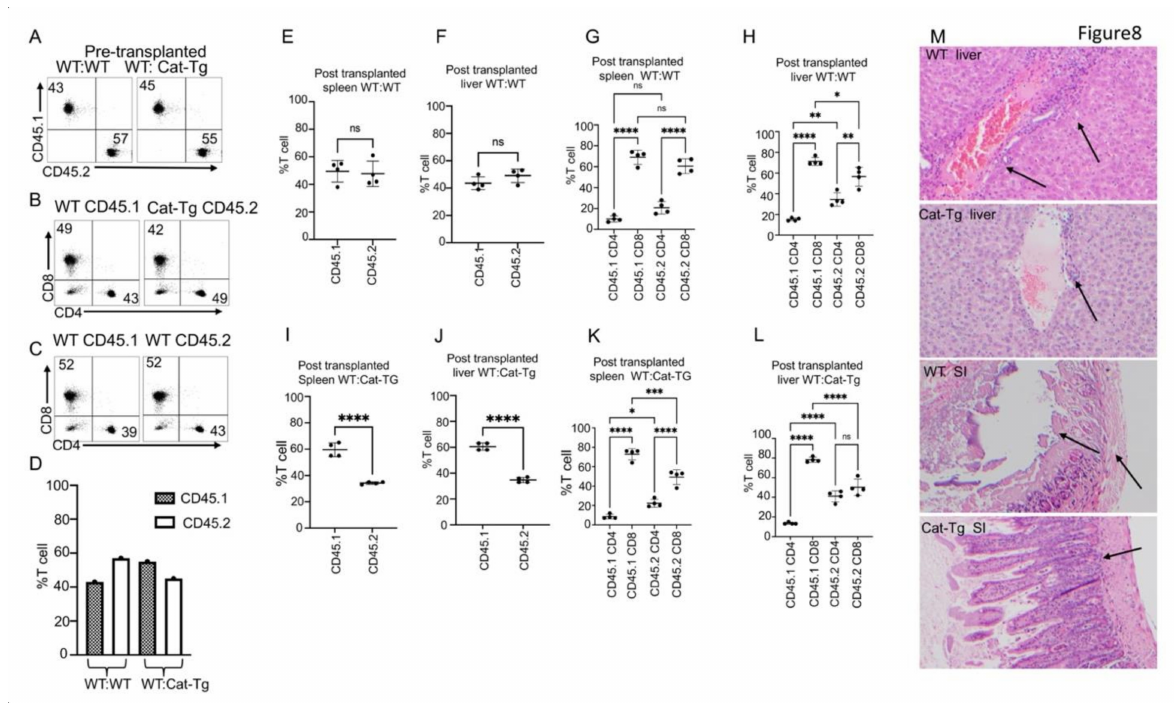
Figure 8. Wnt/ β -catenin overexpression specifically affects CD8 + T cell functions. ( A ) Pre-allo-transplanted MACS-purified WT(CD45.1) and Cat-Tg (CD45.2) cells, and WT(CD45.1) and WT(CD45.2) (as a control) were mixed at a 1:1 ratio. ( B ) Cell mixture of Cat-Tg (CD45.2) cells, and WT(CD45.1) was stained for CD4 and CD8 surface markers. ( C ) Cell mixture of WT (CD45.2) cells, and WT(CD45.1) was stained for CD4 and CD8 surface markers. ( D ) Quantification data of pre-transplanted CD4 and CD8 T cells from CD45.1 WT and CD45.2 WT mice were examined. We also examined CD4 and CD8 T cells from CD45.1 WT and CD45.2 Cat-Tg mice. ( E ) Quantified data from 7 days post-transplantation, when recipient mice were euthanized and examined for donor T cells (CD45.1 or CD45.2) in spleen from the WT(CD45.1): WT(CD45.2) mice. ( F ) Quantified data for donor cells in recipient liver from the WT(CD45.1): WT (CD45.2) mice at day 7 post-BMT, looking at CD45.1/CD45.2. ( G ) Donor CD4 and CD8 T cells in recipient spleen from the WT(CD45.1): WT(CD45.2) mice at day 7 post-BMT were compared. ( H ) Donor CD4 and CD8 T cells in recipient liver from the WT(CD45.1): WT(CD45.2) mice at day 7 post-BMT were compared. ( I ) Quantification of donor cells from the WT(CD45.1): Cat-Tg (CD45.2) mice at day 7 post-BMT in recipient spleen were compared, looking at CD45.1/CD45.2. ( J ) Quantification of donor T cells in recipient liver from the WT(CD45.1): Cat-Tg (CD45.2) mice at day 7 post-BMT, looking at CD45.1/CD45.2. ( K ) Comparison of donor CD4 and CD8 T cells in recipient spleen from the WT(CD45.1): Cat-Tg (CD45.2) mice at day 7 post-BMT. ( L ) Comparison of donor CD4 and CD8 T cells in recipient liver from the WT(CD45.1): Cat-Tg (CD45.2) mice at day 7 post-BMT. ( M ) On day 7 post-allo-HSCT, small intestines and liver were examined by (H&E) staining for tissue damage. Arrows show